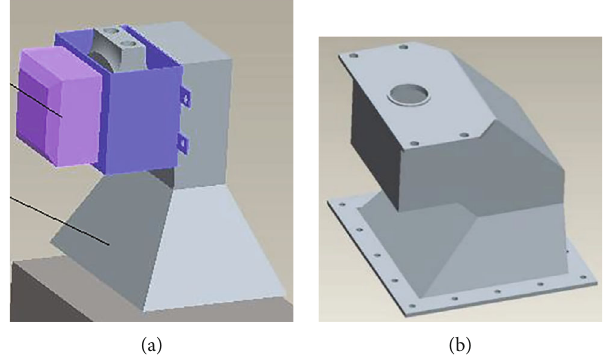
Figure 1: The two kinds of the horn antennas. (a) A straight horn antenna. (b) An oblique horn antenna.